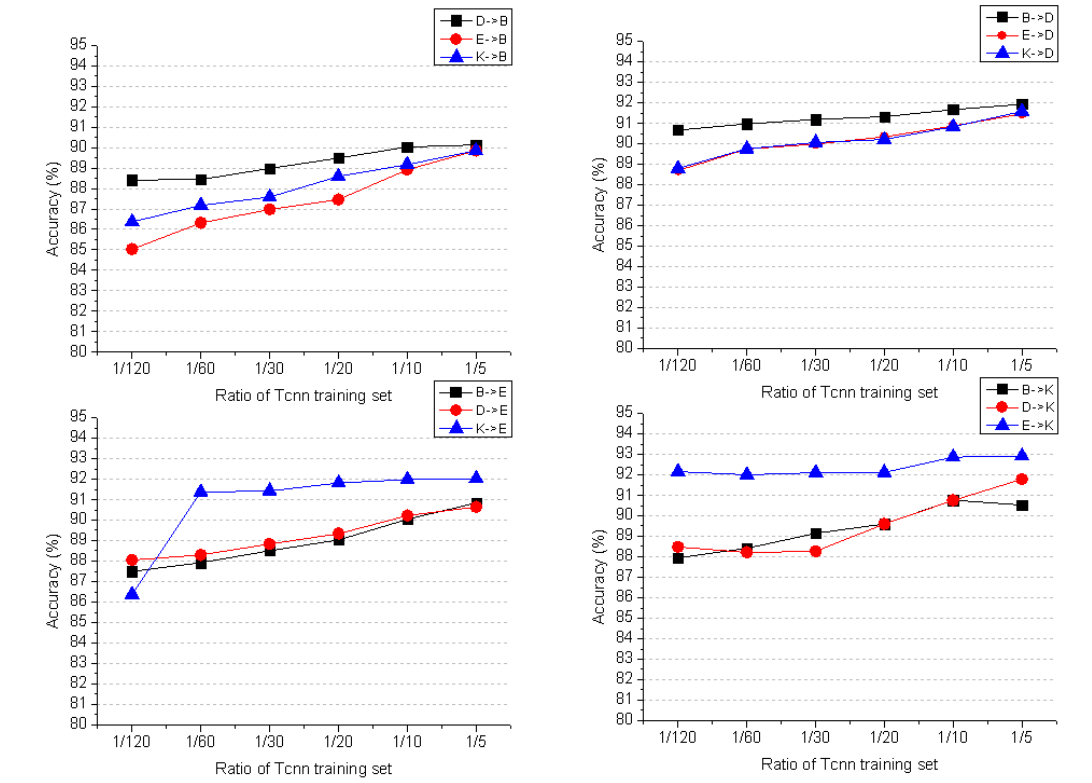
Figure 7. Effect of labeled target domain data ratio for training the T cnn